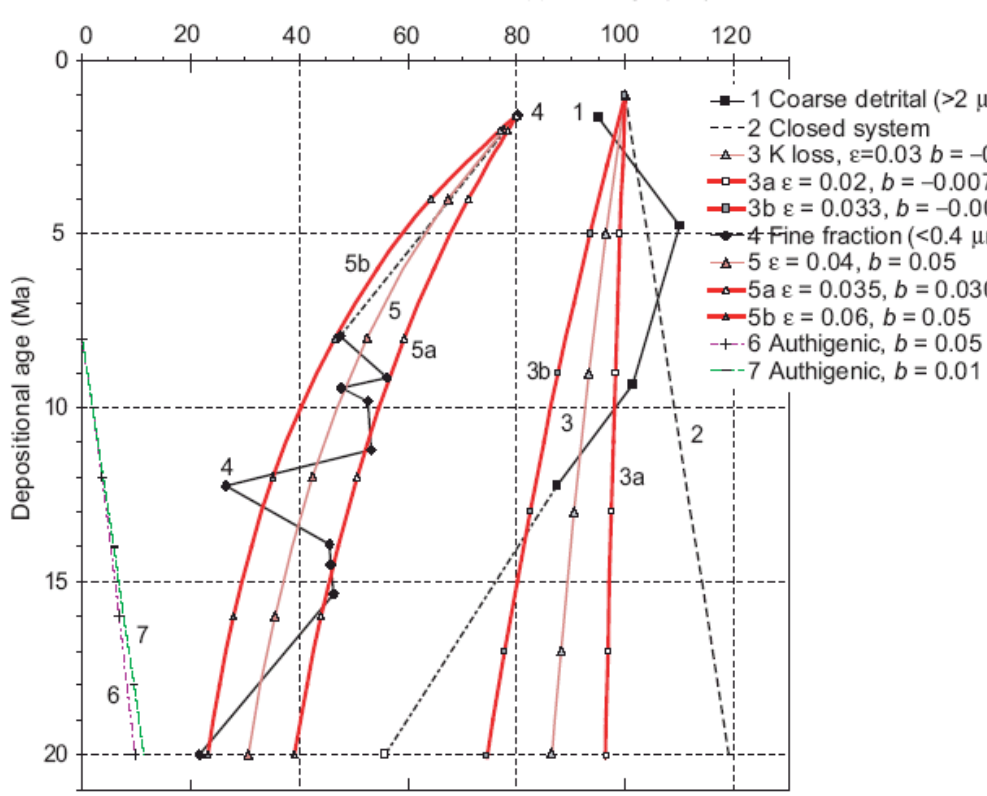
Figure 7. The K-Ar apparent ages of the coarse- (line 1) and fine-grained size fractions (line 4) from Mahakam sandstones. For the coarse fractions, the calculated K-Ar dates of the particles were a closed system (line 2); simultaneous 40 Ar escape and K loss (line 3) and approximately bracketing the data points (curves 3a and b). For the fine fractions, the 40 Ar escape and K addition (curves 5a, b) approximately bracket the data points and curve 5 is for the middle range. Calculated authigenic particle growth by addition of K at different rates (curves 6 and 7), starting at the depositional age of 8 Ma. See Equation (A4b) in the Appendix A.